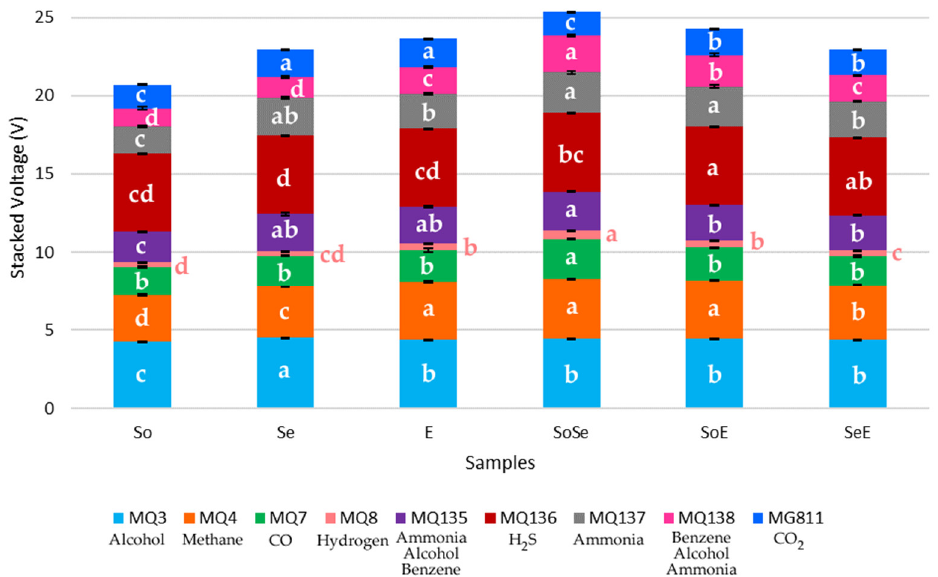
Figure 5. Stacked graph showing the mean voltage of the nine different gas sensors integrated into the electronic nose. Different letters a–d depict significant differences between samples based on the ANOVA and Tukey’s honest significant difference (HSD) post hoc test (α = 0.05). Abbreviations: So: soft wheat; Se: semola; E: Emmer wheat; SoSe: soft wheat and semola; SoE: soft and Emmer wheat; SeE: semola and Emmer wheat; CO: carbon monoxide; H 2 S: hydrogen sulfide; CO 2 : carbon dioxide.